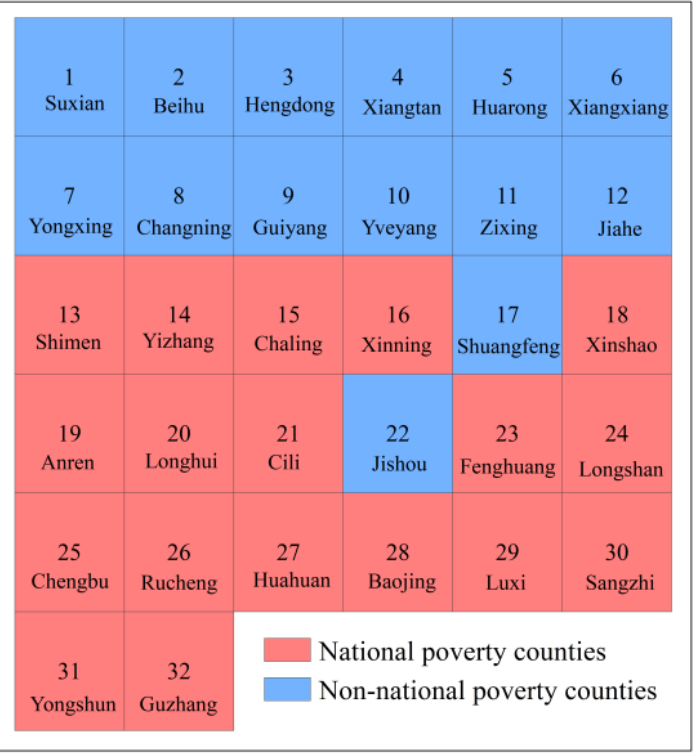
Figure 3. The SDG 1 evaluation value ranking of some districts and counties in Hunan Province, in 2014. For example, Guzhang, ranking 32, was the poorest county and had the lowest SDG 1 evaluation value among these 32 counties of Hunan Province, in 2014.